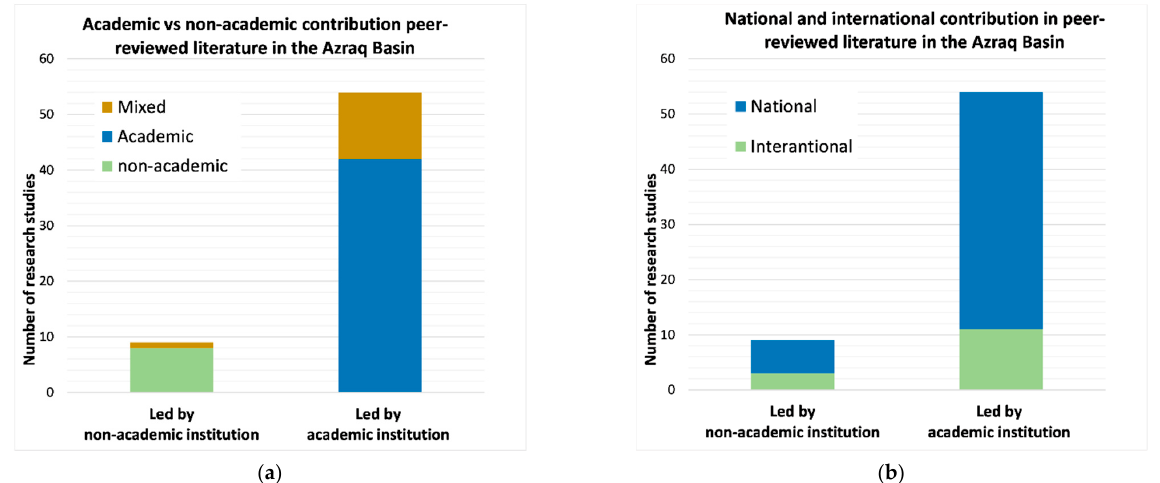
Figure 4. Number of peer reviewed research studies conducted by ( a ) only academic, only non-academic and combination of academic and non-academic institutions, and ( b ) national and international institutions based on the affiliation of the first author of the literature.